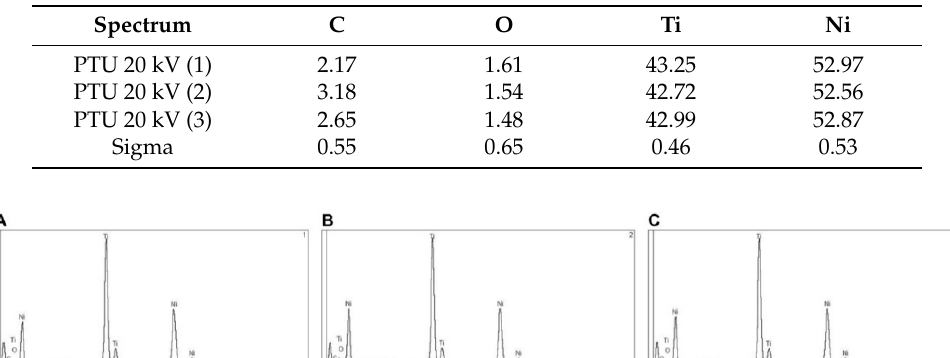
Table 5. Mean atomic weight percent (%) of NiTi alloy PTU endodontic rotary files at 15 kV and 20 kV and three di ff erent locations (1, 2 and 3).